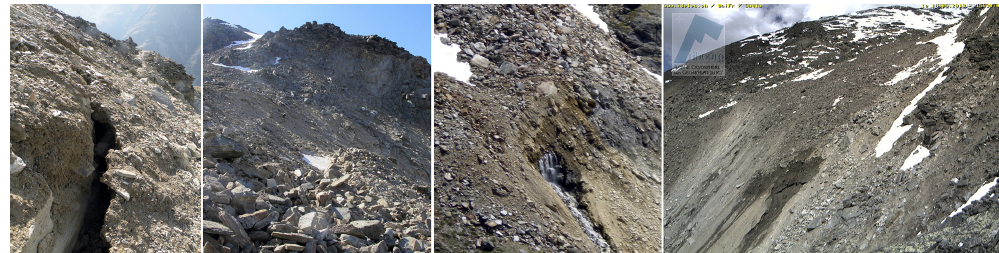
Figure 10. Visible cracks (left, from September 2011) and depressions (middle left, from June 2013) at the front of the rock glacier Breithorn, visible water outflow (middle right) at the front of rock glacier Dirru (from June 2013), and a webcam image of the front of rock glacier Breithorn (right, from 14 June 2013).